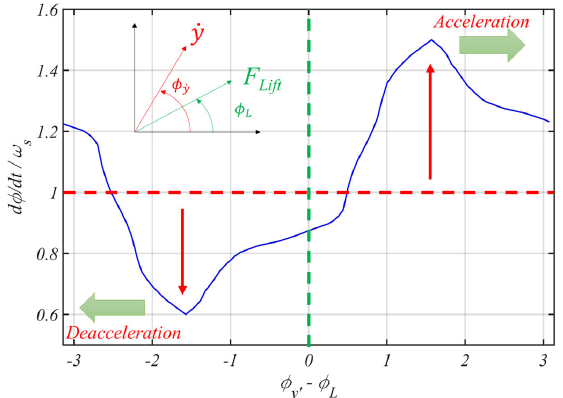
Figure 3. Lift phase model for synchronization ([25]).